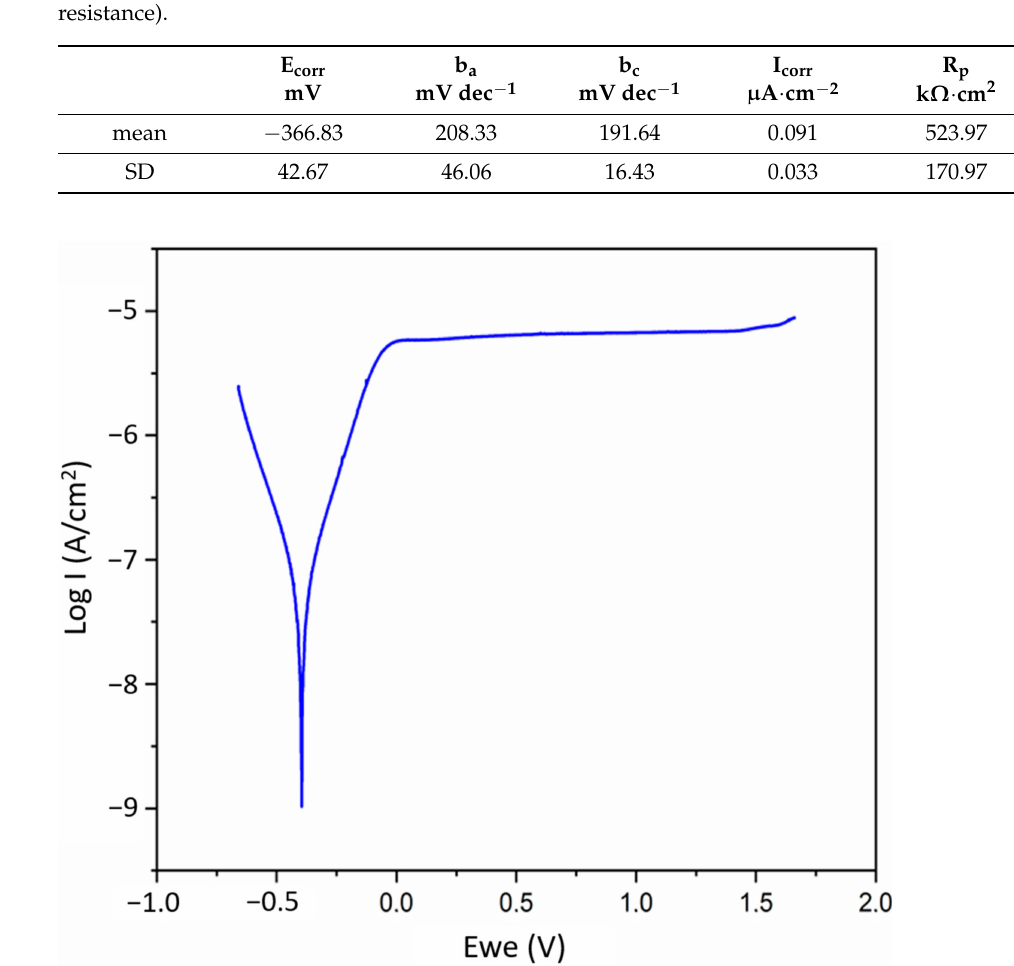
Figure 14. Potentiodynamic polarisation curve, recorded in Ringer’s solution at room